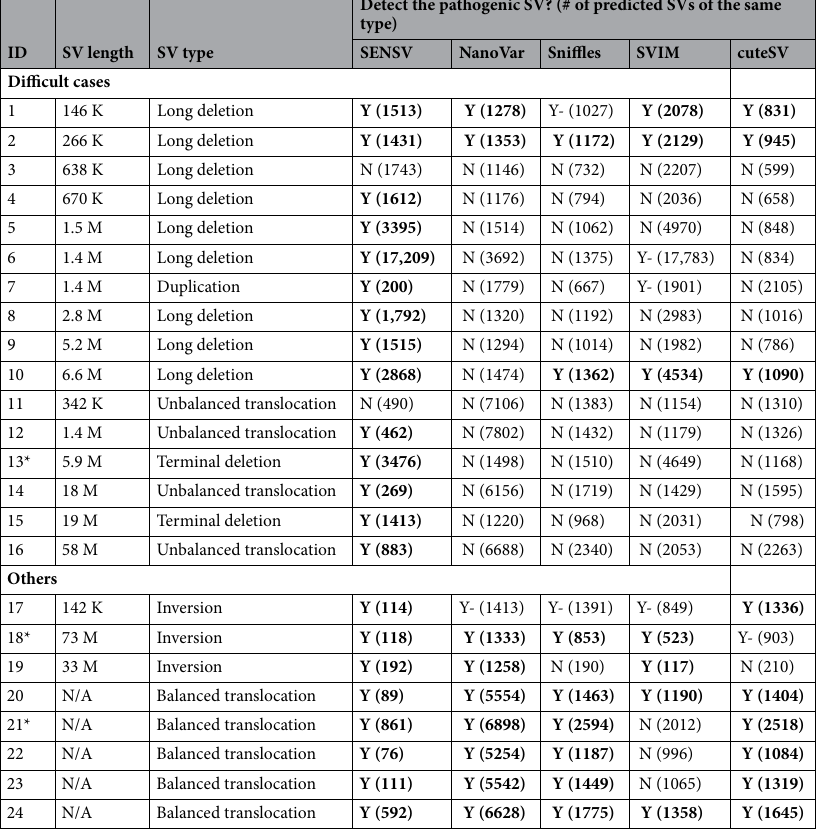
Table 1. Comparison of SENSV, NanoVar, Sniffles, SVIM and cuteSV on the ability to detect the pathogenic SV from the 24 patients’ ONT WGS data. Below, “Y” [and “Y-”] mean that a method can detect the pathogenic SV with correct SV type and with breakpoints off by at most 100 bp [and by at most 2000 bp respectively]; and “N” indicates the method unable to detect the SV with breakpoints off by at most 2000 bp. SENSV can detect more SVs, especially for difficult cases, with much fewer false positives. Other software usually detects much more SVs than SENSV but most of them are false positives. The samples ID with asterisk have been basecalled using both Guppy versions (v3.1.5 and v5.0.11). The best results of a row are in